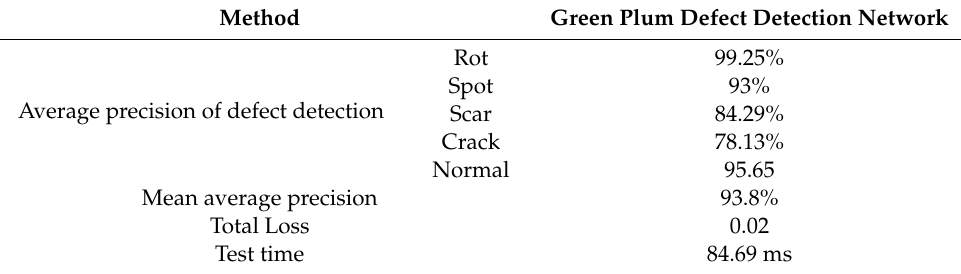
Table 3. Results of green plum defect detection.